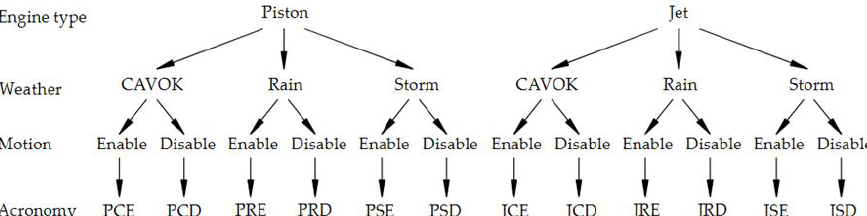
Figure 3. Names of scenarios used in research which are a combination of engine type, weather set and motion system.